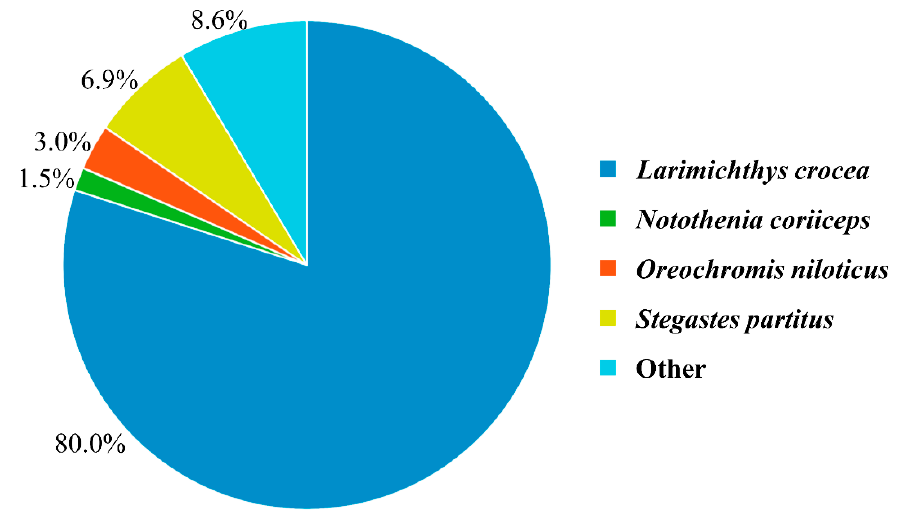
Figure 4. Species that match the annotated sequences of L. crocea . The species distribution is based on the results of the Nr annotation. The percentages of contigs that are homologous with other species are presented.